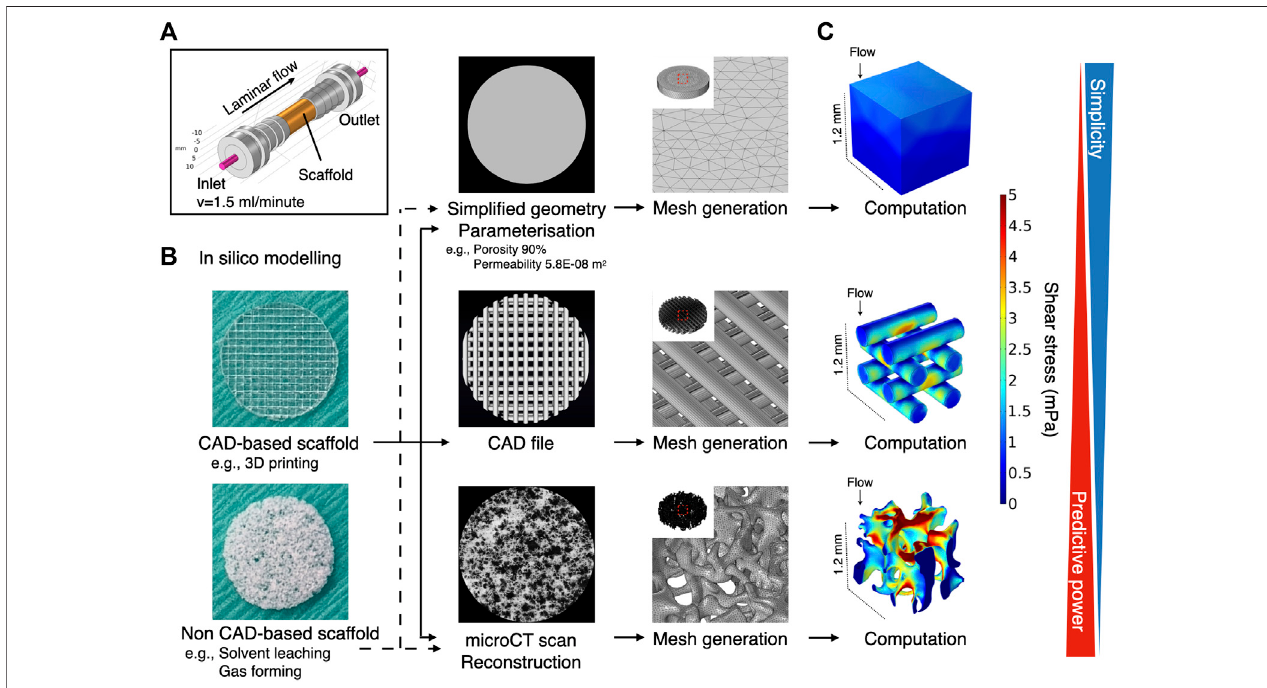
FIGURE 8 | Schematic illustration of common methods for computational fl uid dynamic simulation in scaffold-based perfusion cell culture. (A) Expedient culture chamber design. Porous scaffolds were placed in the culture chamber and perfused at 1.5 ml/min. (B) The computational reproduction of scaffold geometry can be undertakenusingdifferentmethodologies,dependingontheavailabilityofhardwareresourcesandfeasibility.Atitssimplest,expedientgeometry(e.g.,acylinder)maybe assigned as a porous domain where porous parameters are input. The generated mesh for such a geometry tends to be coarse, being less demanding computationally. Alternatively, CAD data may be used when the scaffold is designed in CAD software (e.g., 3D printed scaffold). The mesh required for computation tends to be fi ner than the simpli fi ed geometry, but regular. The highest predictive power may be expected when microCT data are imported to acquire the actual geometry used in the study. Mesh generation and computation entail high computational time and costs. (C) The Darcy (-Brinkman) model may be applied to calculate shear stress for porous domain, whereas laminar fl ow may be de fi ned by the Navier-Stokes equation by assuming that culture medium is an incompressible Newtonian fl